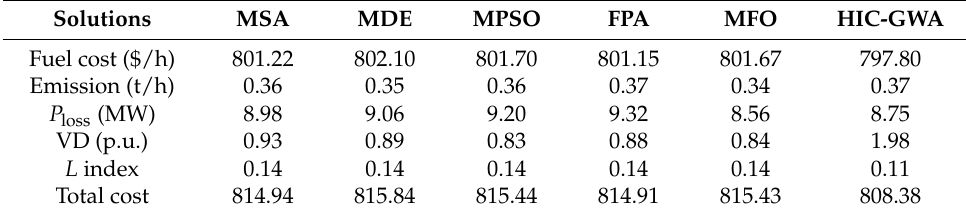
Table 13. Comparison of the proposed approach with different approaches for case 8.